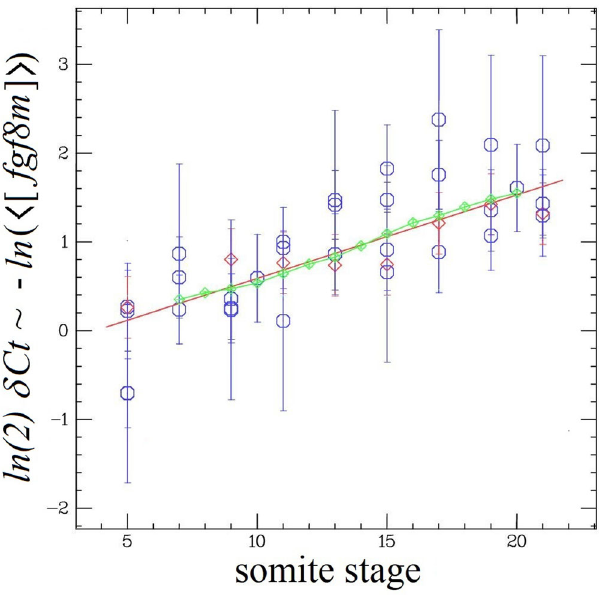
Fig. 5 Variation of the fgf8 mRNA concentration with somite stage. Negative ln (<[ fgf8m ]>) ( = ln(2) δ Ct values from the RTqPCR data) at different somitic stages (blue ○ : whole embryo; red ◊ : PSM only). Red line: linear best fi t ( y = ax + b ) with a = 0.094 ± 0.013 ( Χ 2 = 22; DF = 36), corresponding to a an exponential decrease of <[ fgf8m ]> with a time constant τ = 1/ a ≅ 11 somitic periods, Eq. (1). Green ◊ : - Δ PSM/ λ with λ = 260 μ m and the PSM shrinkage, Δ PSM, taken from Fig. 4e. From the